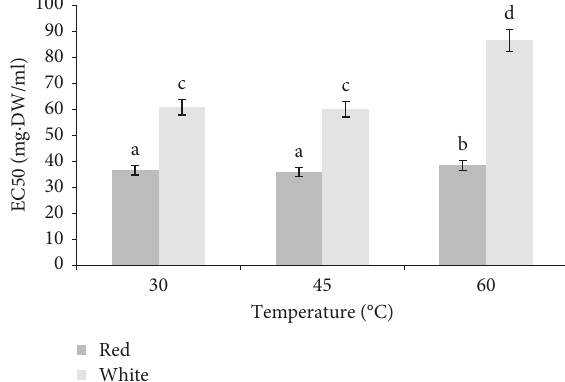
Figure 3: Comparison of OH radicals scavenging activity of red and white quinoa sprouts extracts.